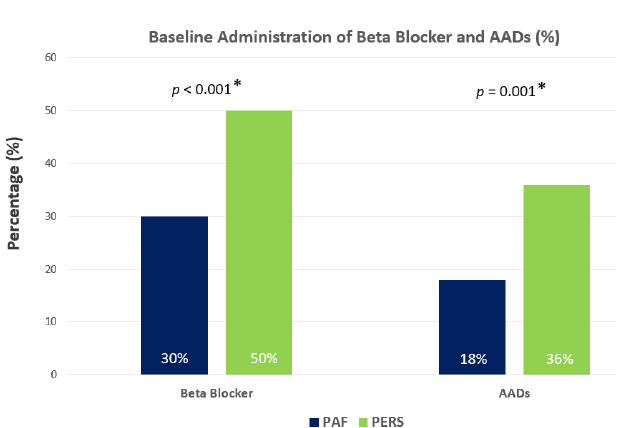
Figure 2. Baseline administration of beta blocker and AADs. AADs, antiarrhythmic agents, PAF, paroxysmal atrial fibrillation, PERS, persistent atrial fibrillation, mFU, months follow-up, p , p -value, * indicates statistical significance.